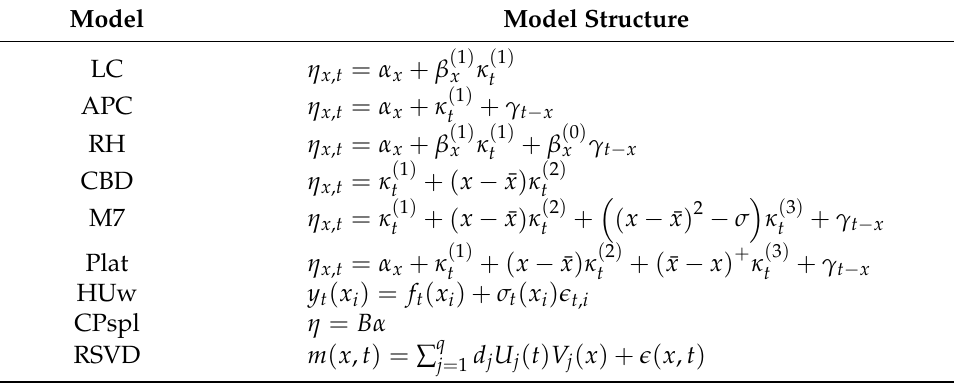
Table 1. Analytical structure of the stochastic mortality models used in this study.